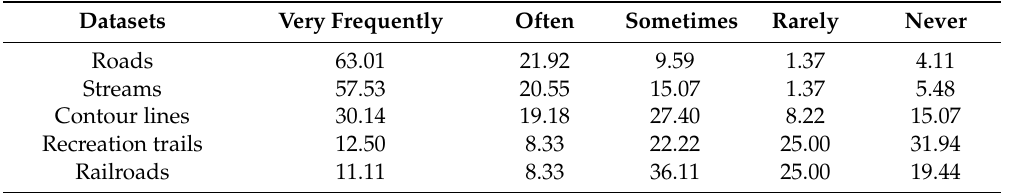
Table 4. Frequency of use (percent of respondents) of vector line datasets by recent graduates from forestry programs at Mississippi State University, Oregon State University, and the University of Georgia.